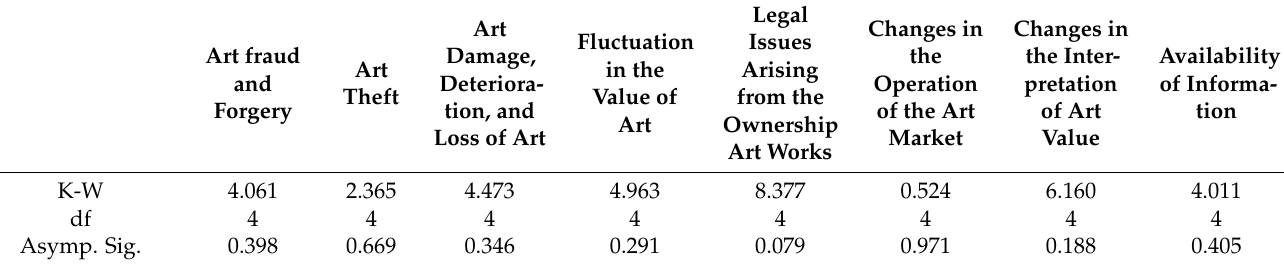
Table 20. Effects of years of experience in the industry on art risk perception. Test statistics a,b